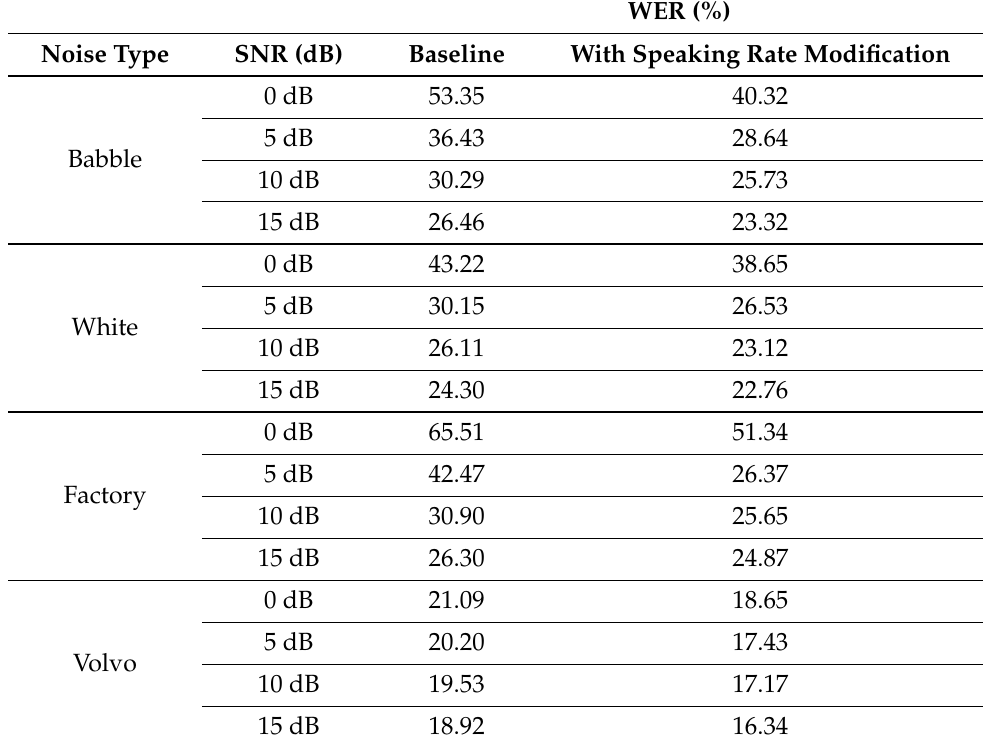
Table 5. WERs obtained in recognizing noisy children’s speech of four noise types in four SNR categories using speaking rate modification. The baseline system is the same as in Table